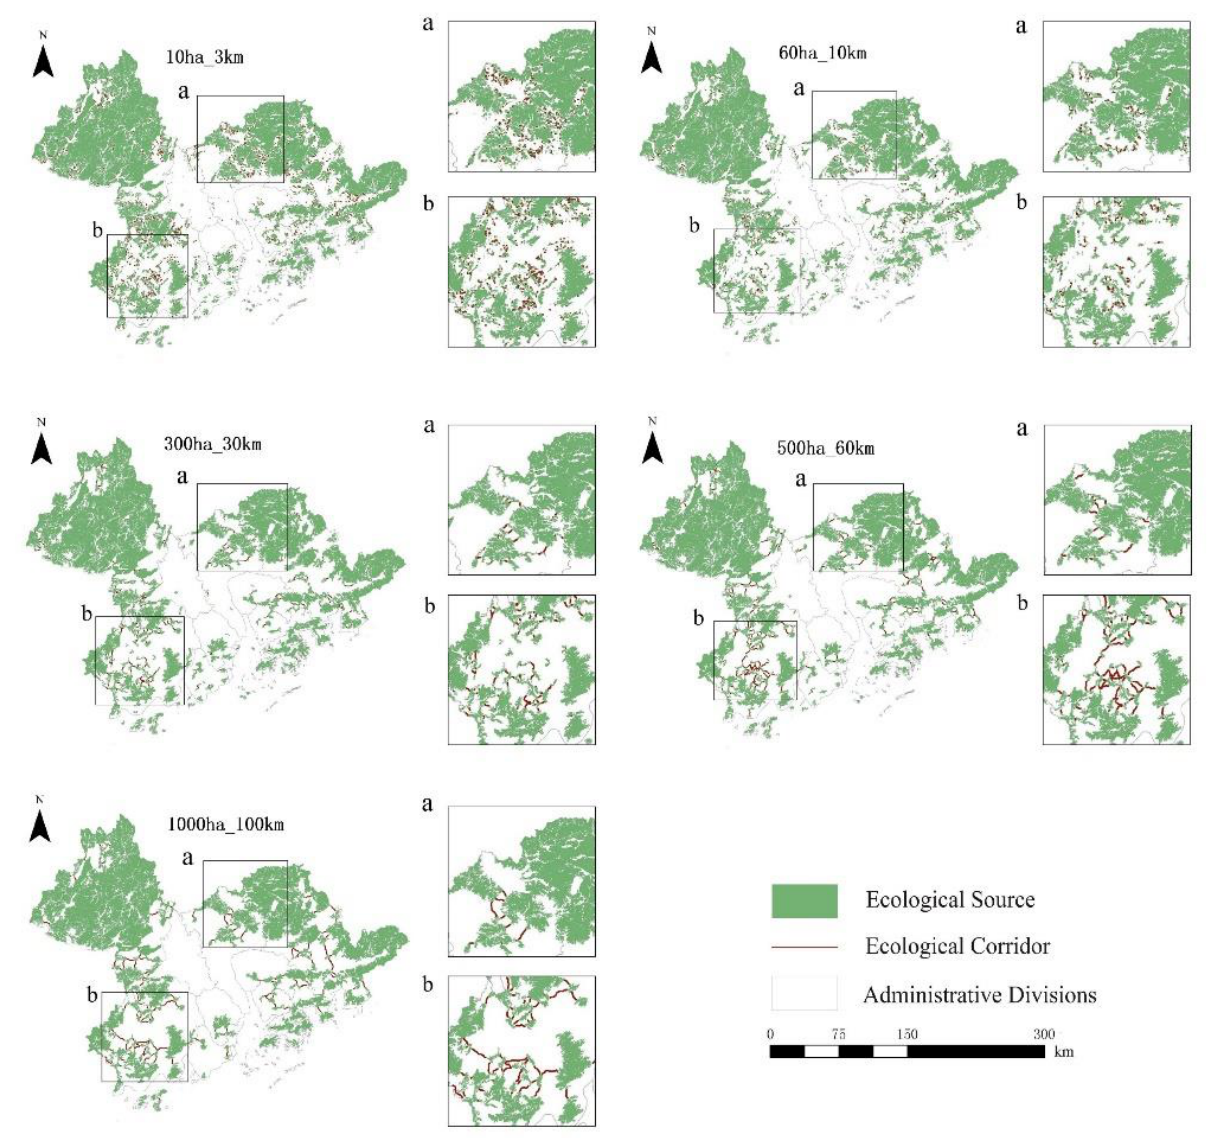
Figure 7. Five Scattered Scale Ecological Networks in the Guangdong–Hong Kong–Macao Greater Bay Area in 2020.